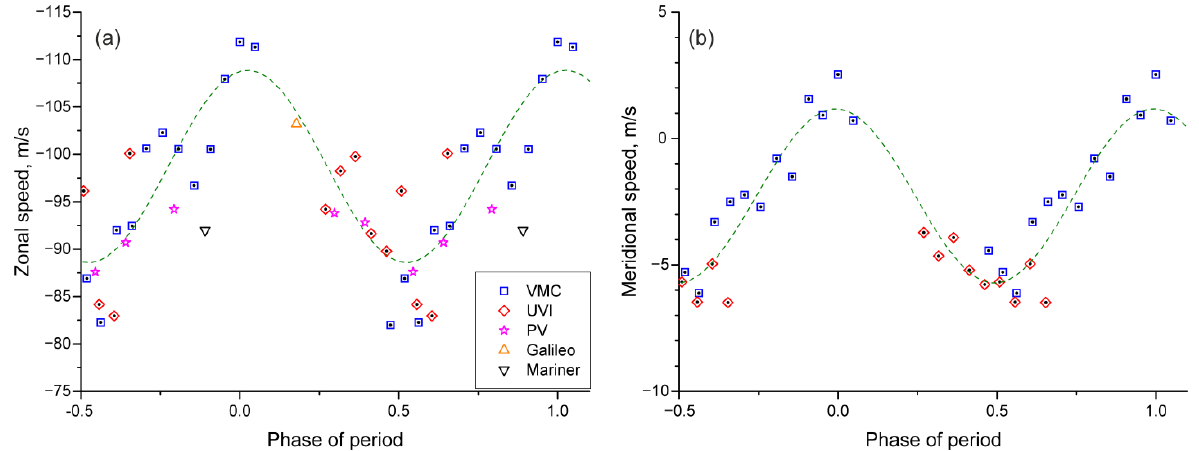
Figure 3. Phase curves of the zonal ( a ) and meridional ( b ) components of the wind speed for the trial period of 12.5 years. Color symbols denote wind measurements by different missions. The green dashed line is the sine approximation of the phase curves.